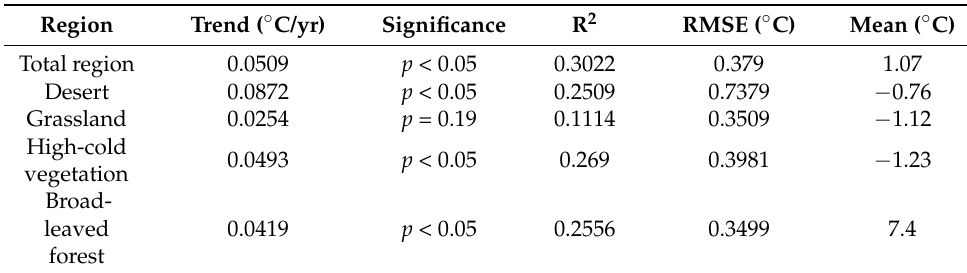
Table 4. Trend analysis and mean value of temperature on each